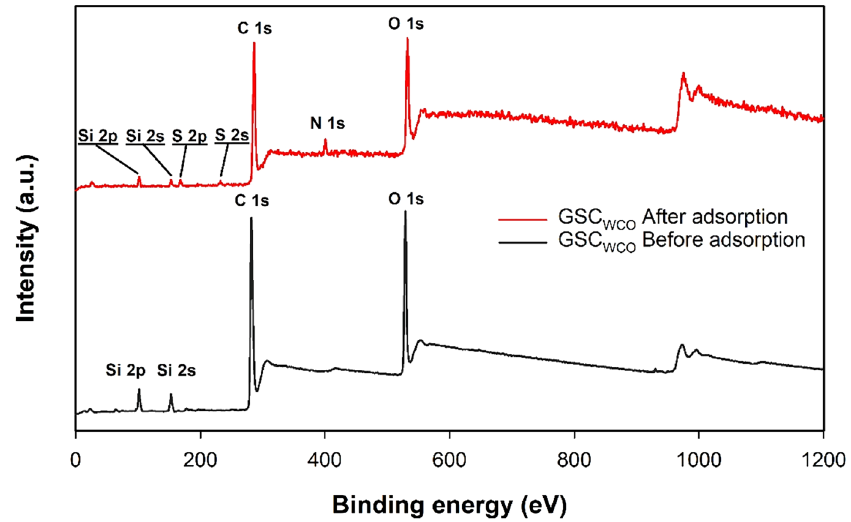
Figure 17. XPS survey spectra of GSC WCO before and after